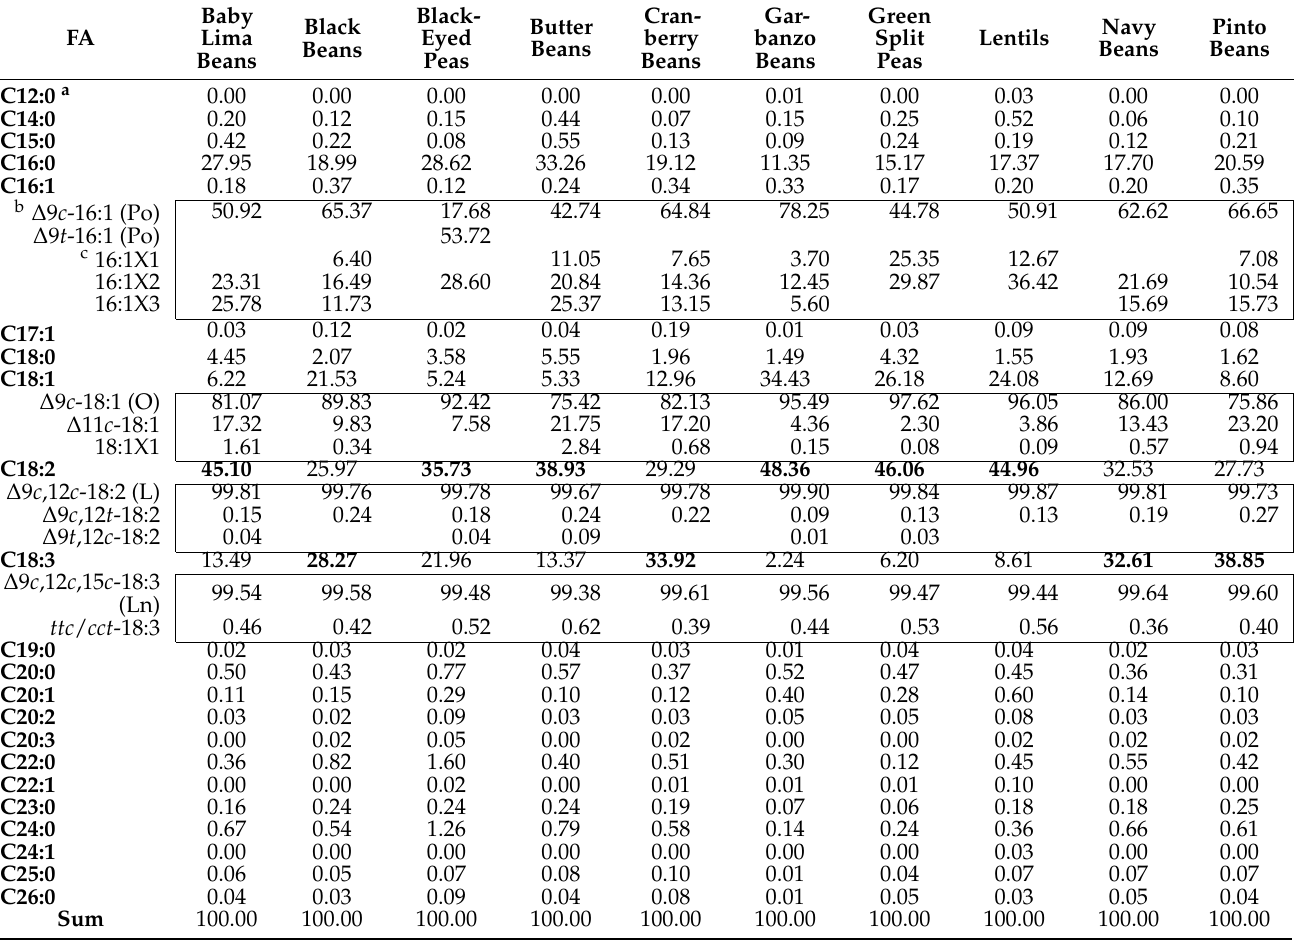
Table 1. Fatty acid compositions of pulses determined as the fatty acid methyl esters (FAME) by gas chromatography with flame ionization detection. Left-justified values are fatty acids by carbon number:degree of unsaturation. Right-justified values are the compositions of isomers of the value above. Fatty acids and most abundant FA percentages in